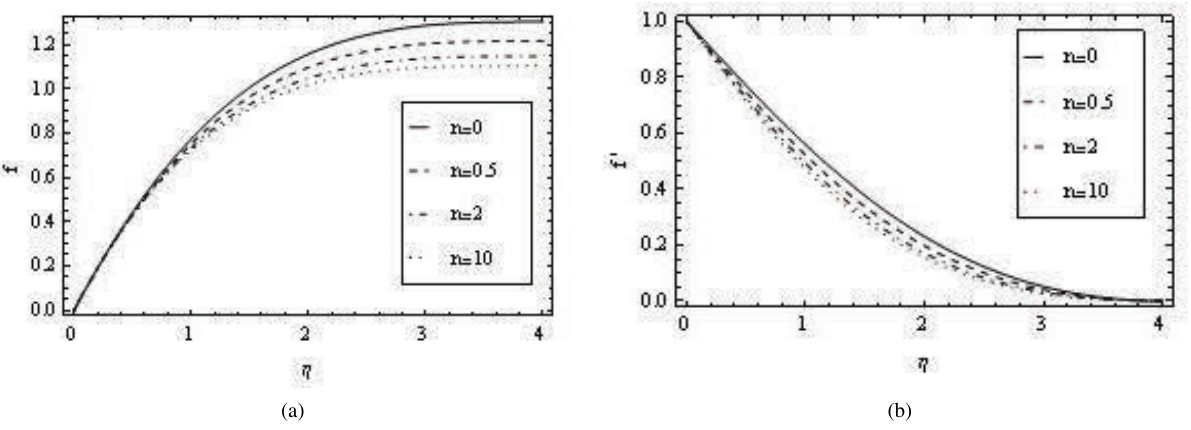
Figure 2. The influence of non linear stretching sheet parameter n when ˇ D 0:4 on: (a) the stream function f .(cid:17)/ and (b) the velocity f 0 .(cid:17)/ .